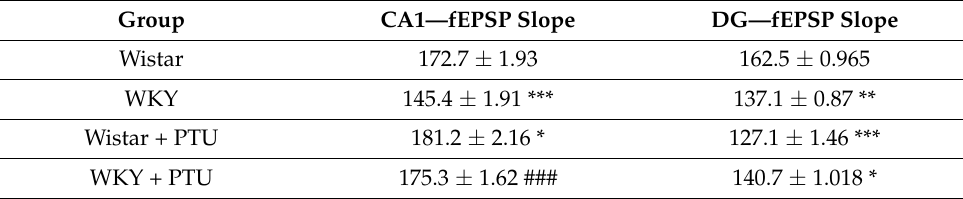
Table 4. Mean slope of FPs recorded between 45 and 60 min after HFS in the CA1 and DG regions of the hippocampus. * p < 0.05, ** p < 0.01, *** p < 0.001 vs. the control group (Wistar rats); ### p < 0.001 vs. WKY